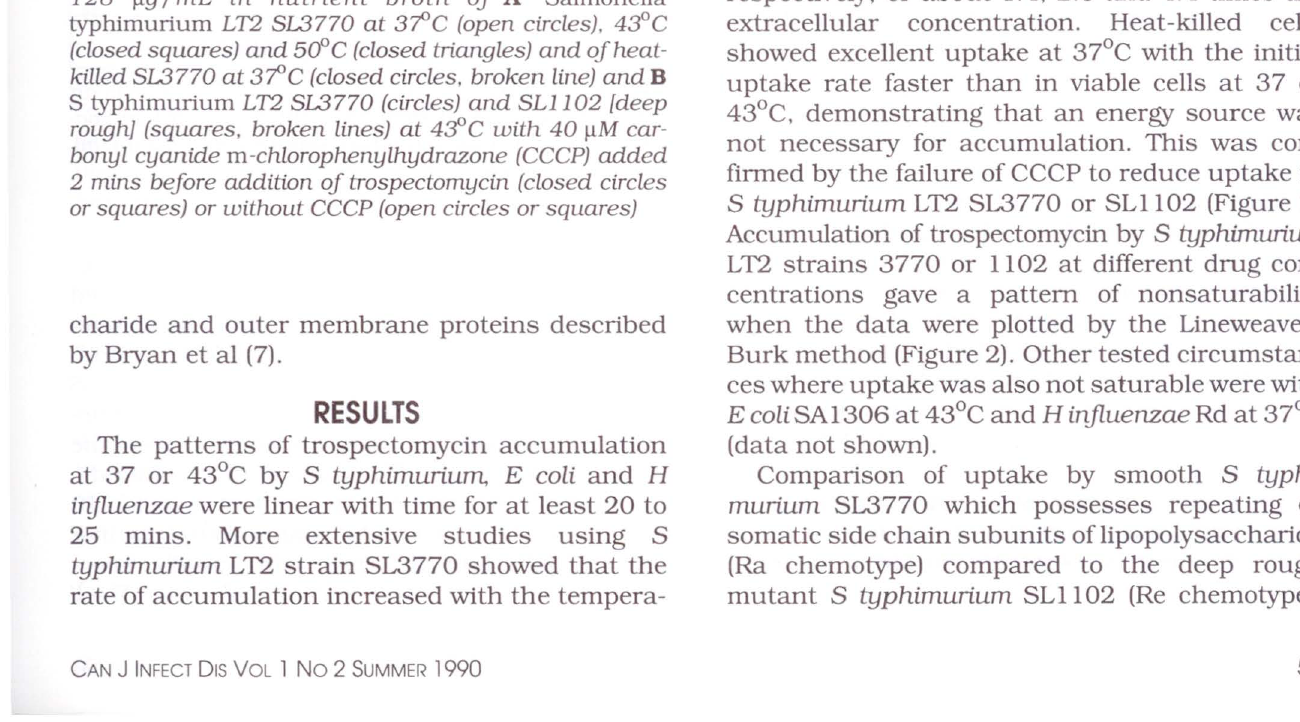
ture used for uptake determination, although the rate levelled off after 15 mins when uptake was done at 50°C (Figure 1). If it is assumed that all of the drug accumulated after zero time was intracel lular, and that there is 1.6 )..lL cell water/mg cells (8), the intracellular concentrations at 37, 43 and respectively, or about 1.4, 2.8 and 4.4 times the